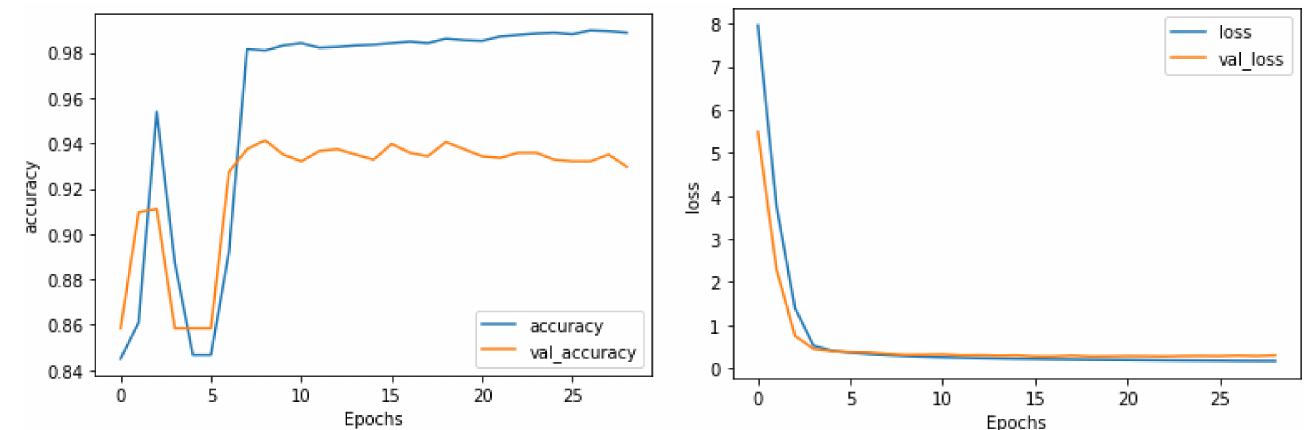
Figure 10. The data training process using GRN.